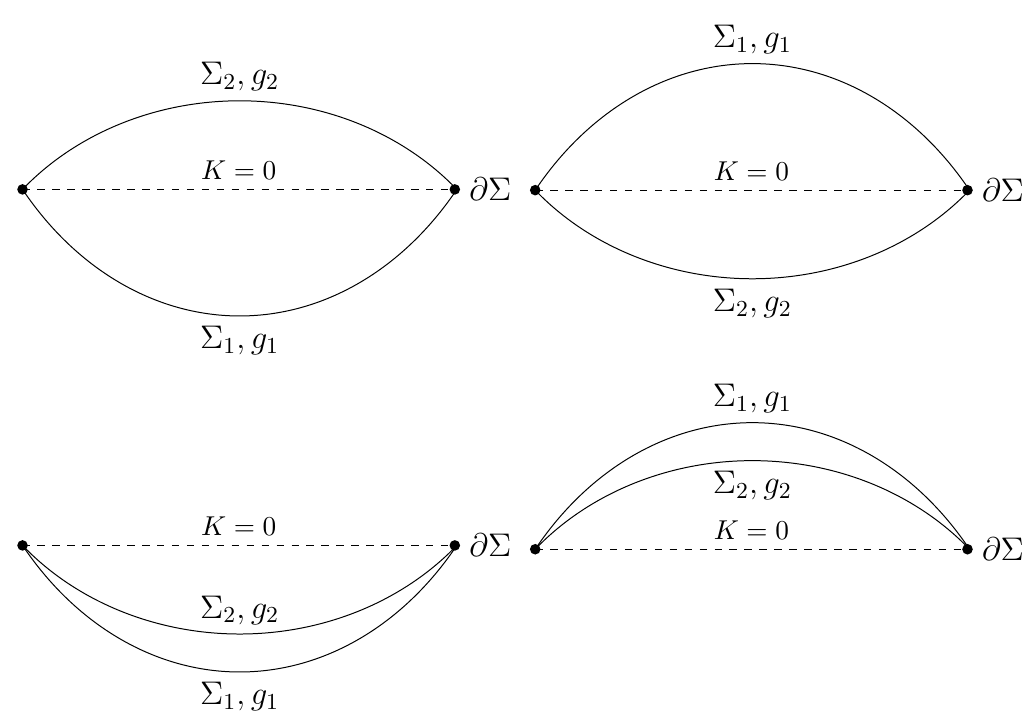
Figure 5 . For the case of the slices consistent with Lorentzian embedding, we get 4 saddles. The top two “gibbous” saddles are time reversals of each other and so they together contribute as a complex conjugate pair to the transition amplitude. Similarly for the bottom two “crescent” saddles. In this figure the time orientation is directed upwards and the K = 0 dashed line is the time symmetric slice. It can be seen that when g = g , the crescent saddles go to zero lapse, leading to divergences 1 2 of the 1-loop quantum determinant ∆ , which will be discussed in section crescent